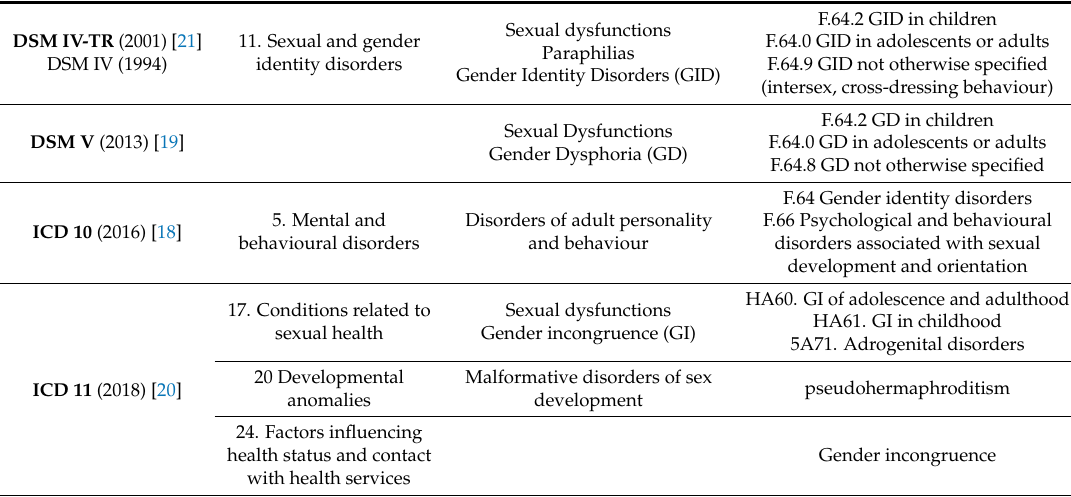
Table 1. ICD and